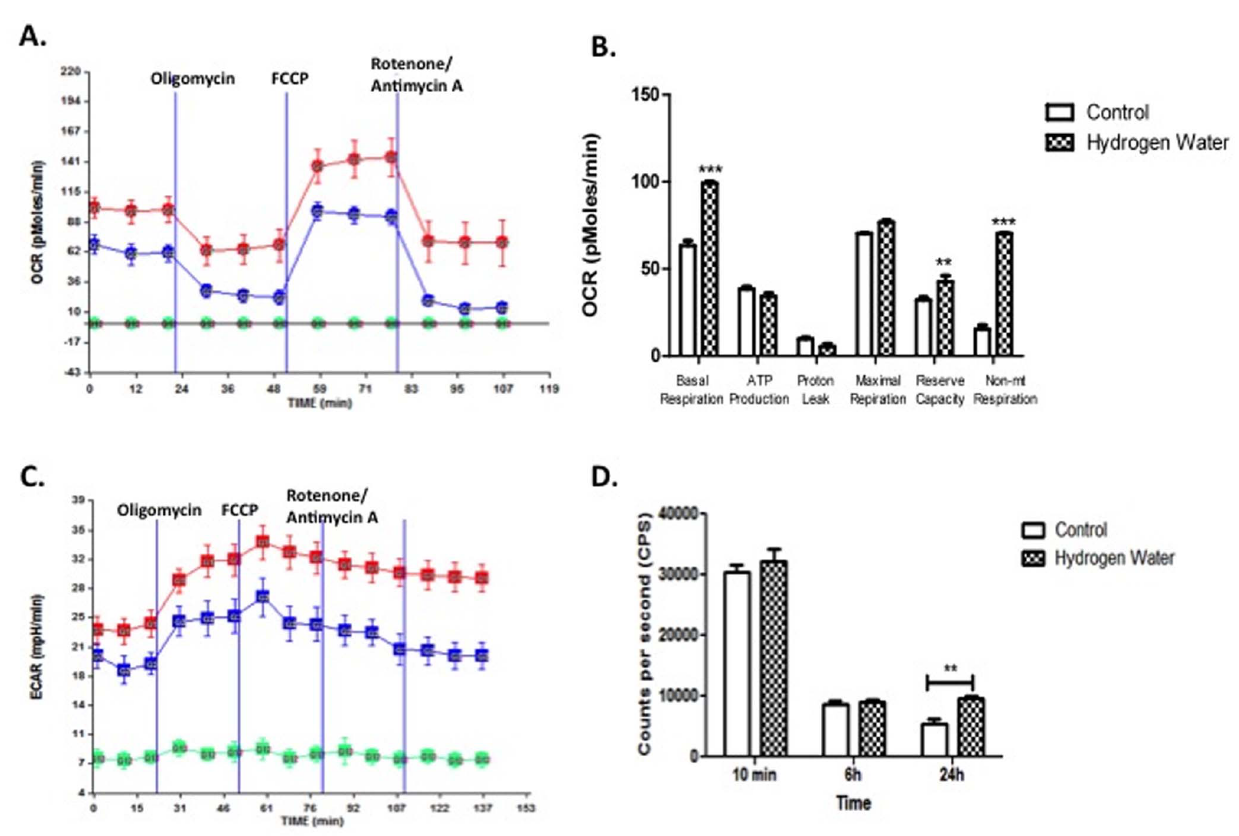
Figure 10. Pretreatment with Molecular Hydrogen Enhances Mitochondrial Aerobic Metabolism. ImBPCs were subjected to a mitochondrial stress test after treatment with molecular hydrogen water (red) or control (dI water; blue) for 24 h. Oxygen consumption rates (OCR) (Panel A) and extracellular acidification rates (ECAR) (Panel C) were measured using the Seahorse XF24 analyzer in the presence of the ATP synthase inhibitor (oligomycin; 3 m M), the uncoupling agent (FCCP; 3 m M), the complex I inhibitor (rotenone; 3 m M), and the complex III inhibitor (antimycin A; 1.5 m M). Analysis of OCR data showed molecular hydrogen increased basal respiration, reserve capacity, and non-mitochondrial (non-mt) respiration but had no effects on ATP production rate as assessed indirectly by OCR analysis, proton leak, or maximal respiration (Panel B). Direct measurement of ATP levels (Panel D) in other cells not exposed to the metabolic stressors showed higher levels of ATP after 24 h but not after 10 min or 6 h of exposure to molecular hydrogen. Results presented here are from one experiment completed, which is representative of the 3 experiments that were done. Results are represented as a mean 6 SEM. ** is p , 0.01 and *** is p , 0.001.